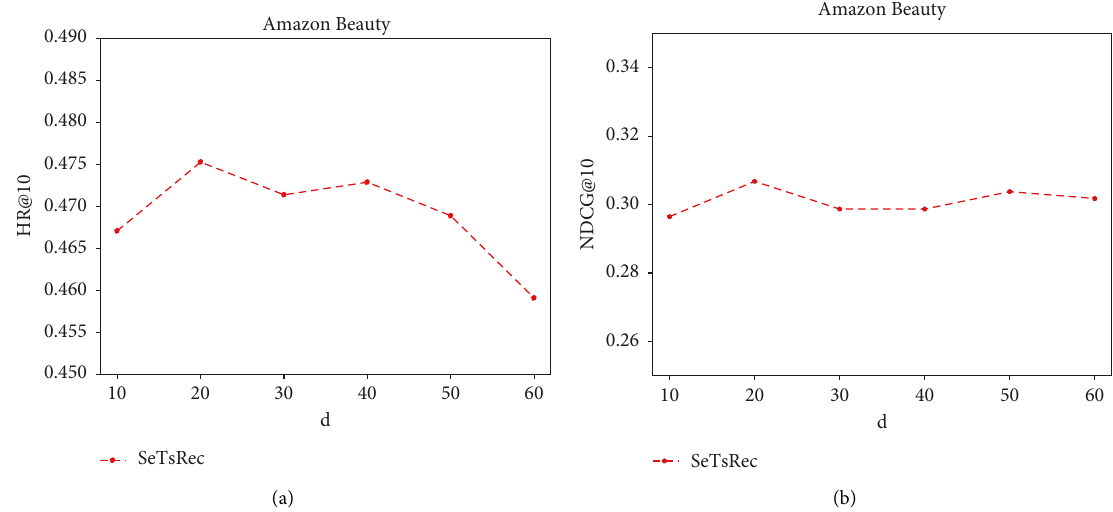
Figure 7: Experiment results of different latent dimension d on AM-BE. (a) Results on HR@10. (b) Results on